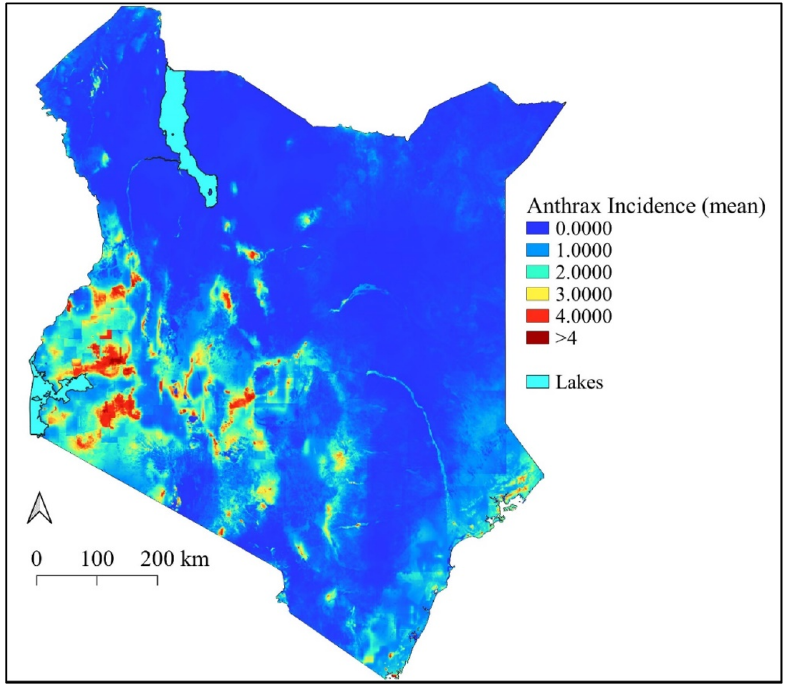
Figure 6. The posterior predicted mean of the incidence of anthrax disease across Kenya from livestock data (2006–2020). The scale for anthrax incidence shows colours ranging from blue to red, with blue showing areas with low incidence and warmer colours towards red showing areas with higher anthrax incidence. This map was generated using Quantum Geographical Information Systems (QGIS) v. 3.16.11 (https:// www. qgis. org/ en/ site/ forus ers/ downl oad. html).